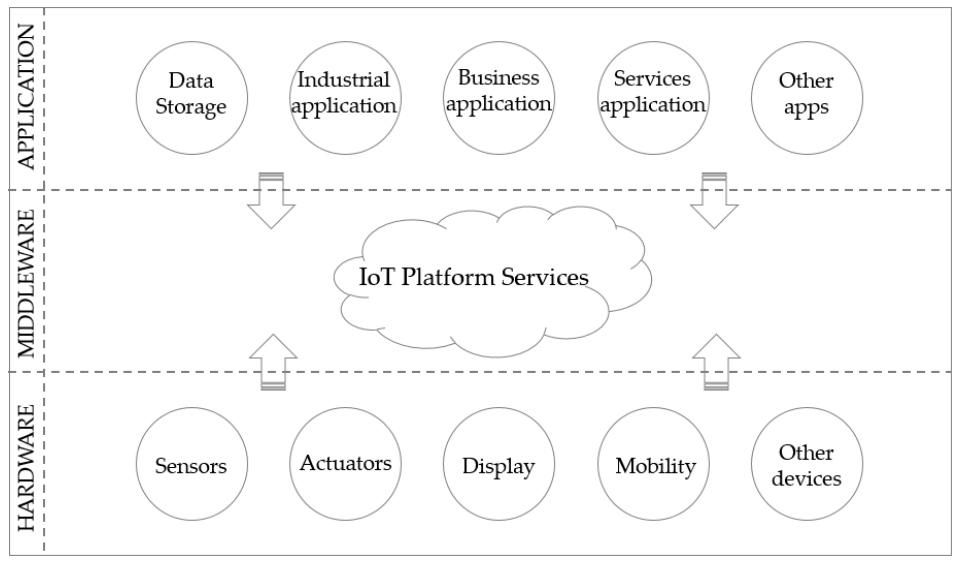
Figure 4. “Internet of Things” (IoT) Platform layer.